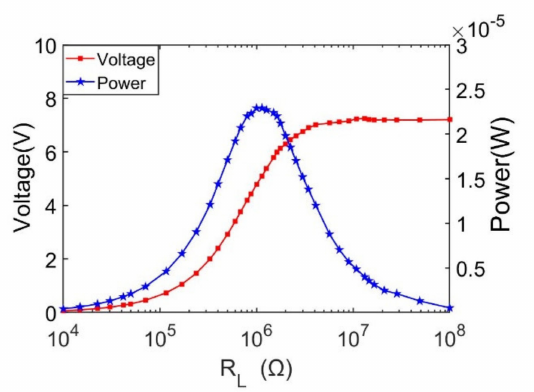
Figure 10. Simulation results of output voltage and power versus load resistance at first mode resonant